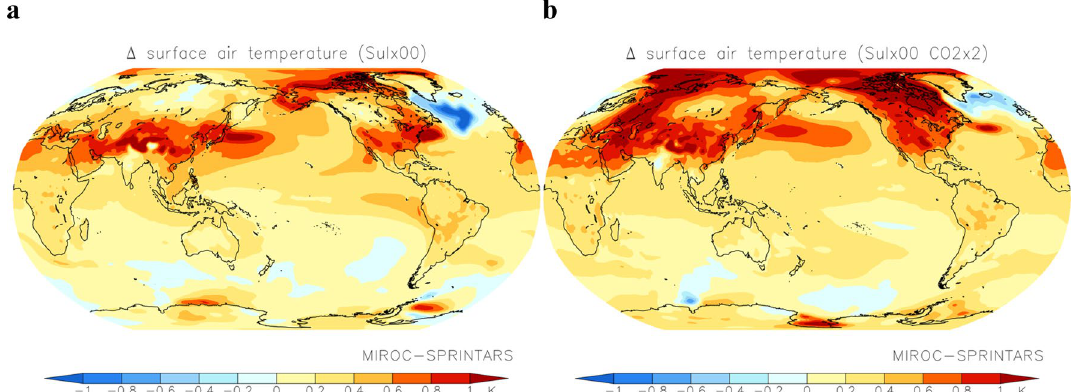
Figure 4. Changes in surface air temperature due to reducing SO 2 emissions to zero. Annual mean distribution of changes in surface air temperature following reduction of SO 2 emissions from fuel sources to zero